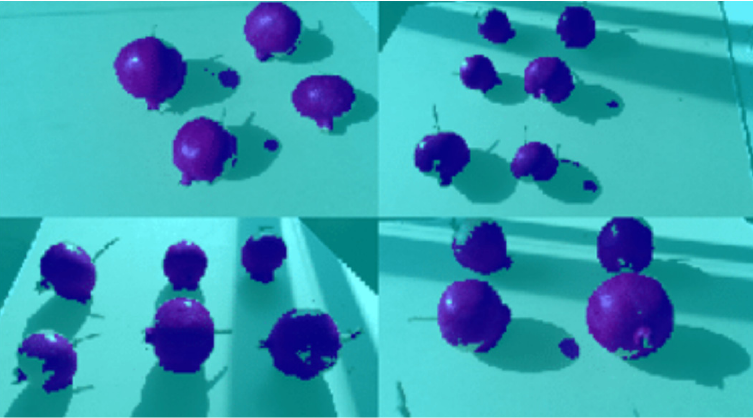
Figure 7. Four segmented images of SET2, in which each pixel recognized as a fruit by the First CE net is blue, while those in the background are cyan.